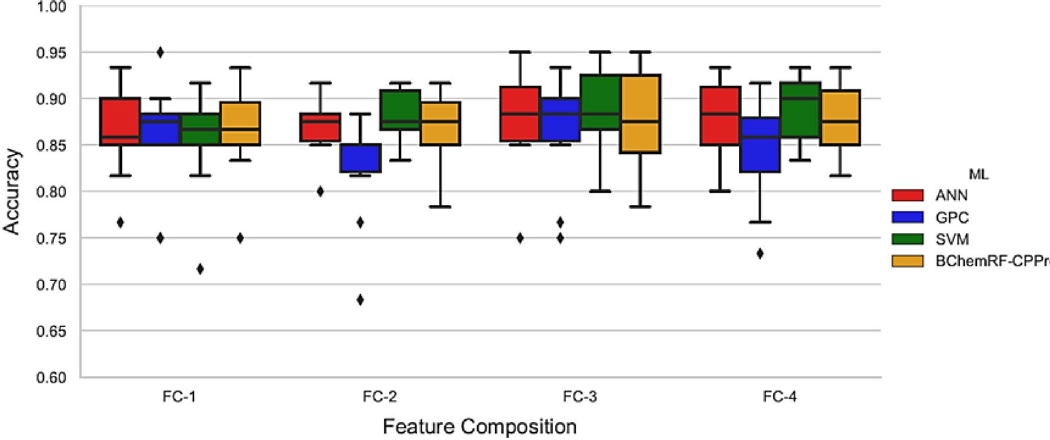
Figure 1. Boxplot of accuracy from tenfold cross-validation of ANN (red), GPC (blue), SVM (green), and BChemRF-CPPred